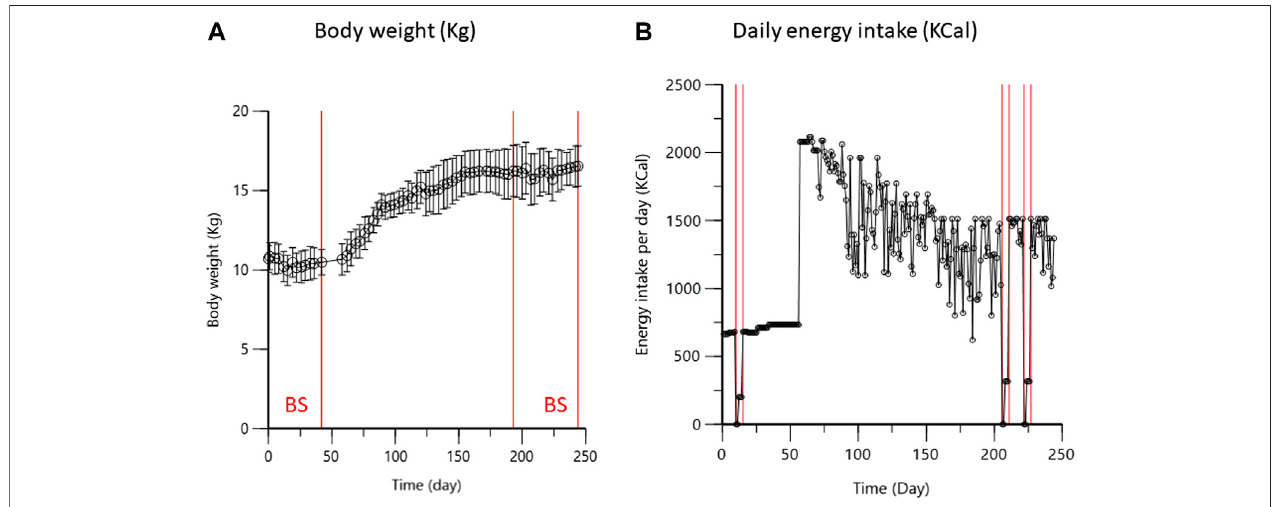
FIGURE 2 | (A) : Time development (days) of body weight (kg) (mean and SD) for the seven dogs. Red vertical lines indicate time of blood sampling (BS) during the fi rst (lean) and second period (obese); (B) : average daily caloric intake (Kcal) for the seven dogs during the study. Red vertical lines indicate episode of energy intake restriction (10 – 15, 206 – 211, and 222 – 227